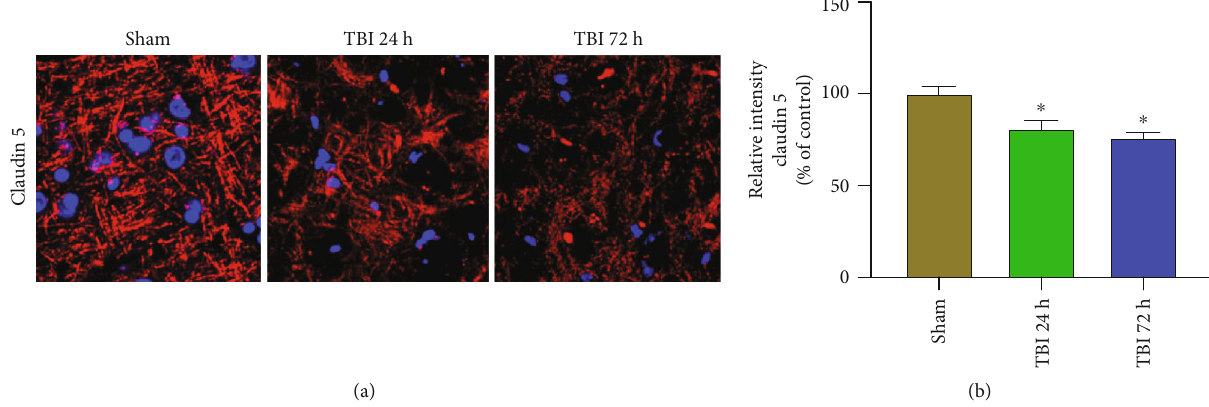
Figure 6: Acute TBI a ff ects claudin 5 expression in the brain. Claudin 5 expression was analyzed in the frozen sections (20 μ m) of the brains after 24h and 72h of weight drop-induced TBI and sham control mouse brains without TBI ( n = 3 mice/group) by immuno fl uorescent staining. Representative images and immunoreactivity intensity bar graphs show decreased/derangement of claudin 5 (red color, white arrows) expression in 24h and 72h acute TBI brains as compared with sham control mouse brains without TBI ( ∗ p < 0 : 05 , sham control vs. TBI). The nuclei were stained with DAPI (blue color). Photomicrograph original magni fi cations=630x.